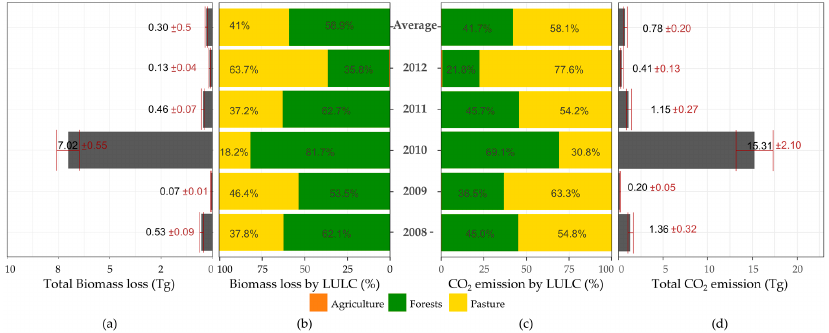
Figure 6. The proportion of biomass loss ( b ) and CO 2 emissions ( c ) by land use and land cover types and the total biomass loss ( a ) and total emissions( d ) through the years analyzed.